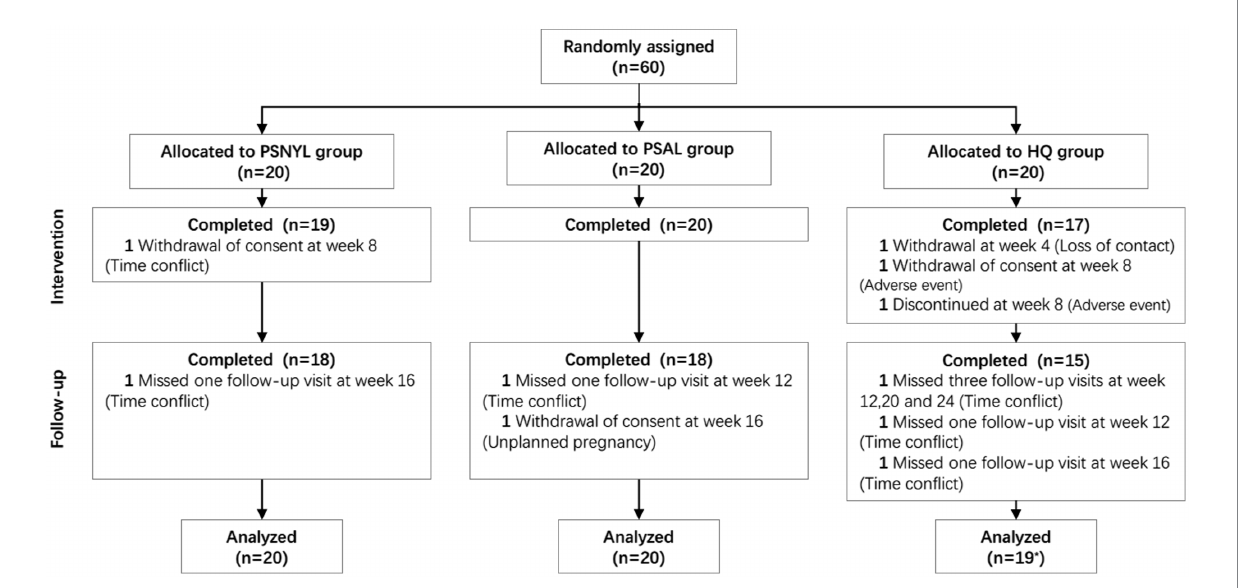
FIGURE 1 Flowchart of participants. PSNYL, picosecond Nd:YAG laser (1,064 nm); PSAL, picosecond alexandrite laser (755 nm); HQ, hydroquinone (2%). * One participant in the HQ group shed early during the intervention period (week 4), and thus was not included in the analysis.